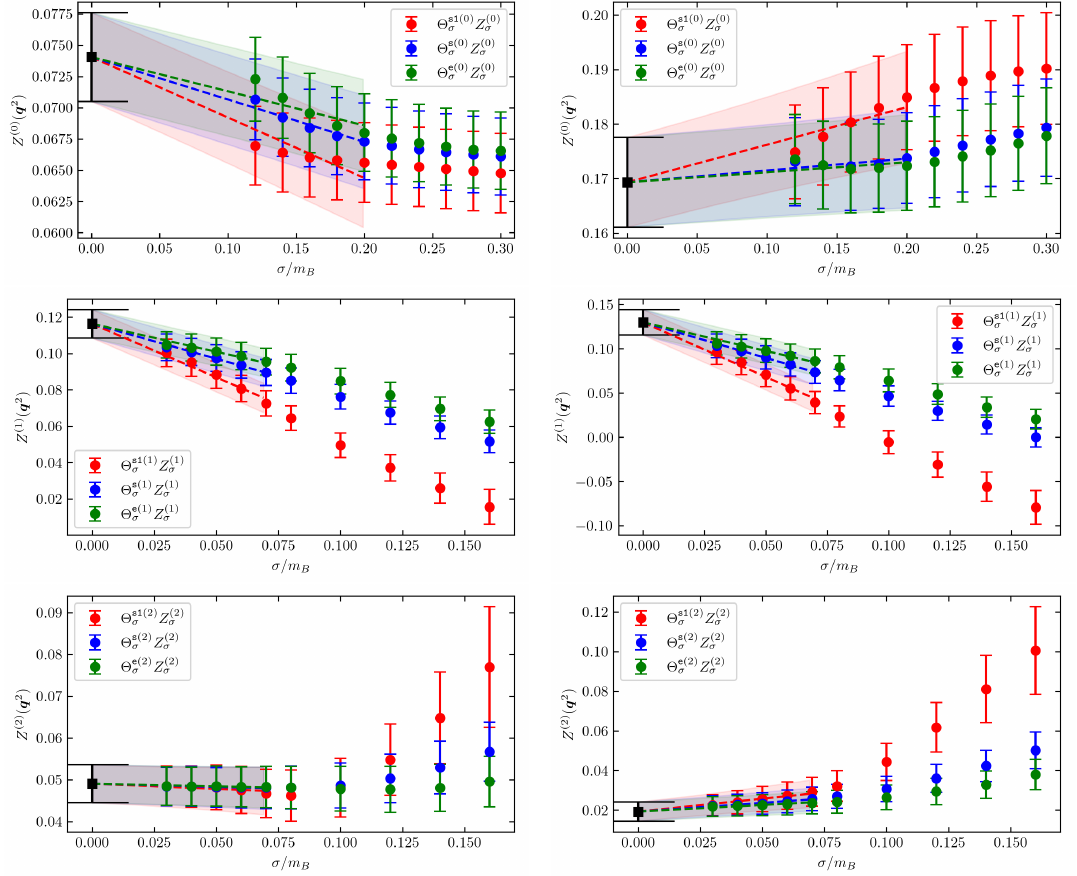
Figure 11 . Combined σ → 0 extrapolations of three contributions Z ( l ) ( q 2 ) to the differential decay rate, see eq. (2.17). The plots on the left correspond to | q | ’ 0 . 5 GeV while those on the right to | q | ’ 0 . 7 GeV. The reconstruction of the kernels Θ (0) σ ( ω max − ω ) is more difficult from the numerical point of view w.r.t. the case of the kernels Θ ( l ) σ ( ω max − ω ) with l = 1 , 2 . In all cases we have obtained results at 10 different values of σ that, in the case of Θ (0) σ ( ω max − ω ) span the region σ ∈ [0 . 12 m B , 0 . 3 m B ] while in the other case we have σ ∈ [0 . 03 m B s s we include the five smallest values of σ into a combined linear extrapolation to quote our results at σ = 0